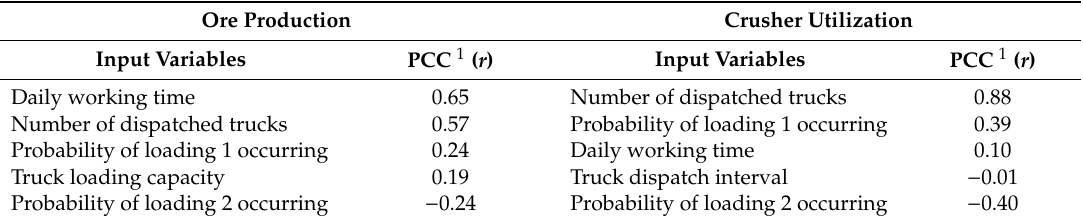
Table 3. Results of correlation analysis between input variables, ore production, and crusher